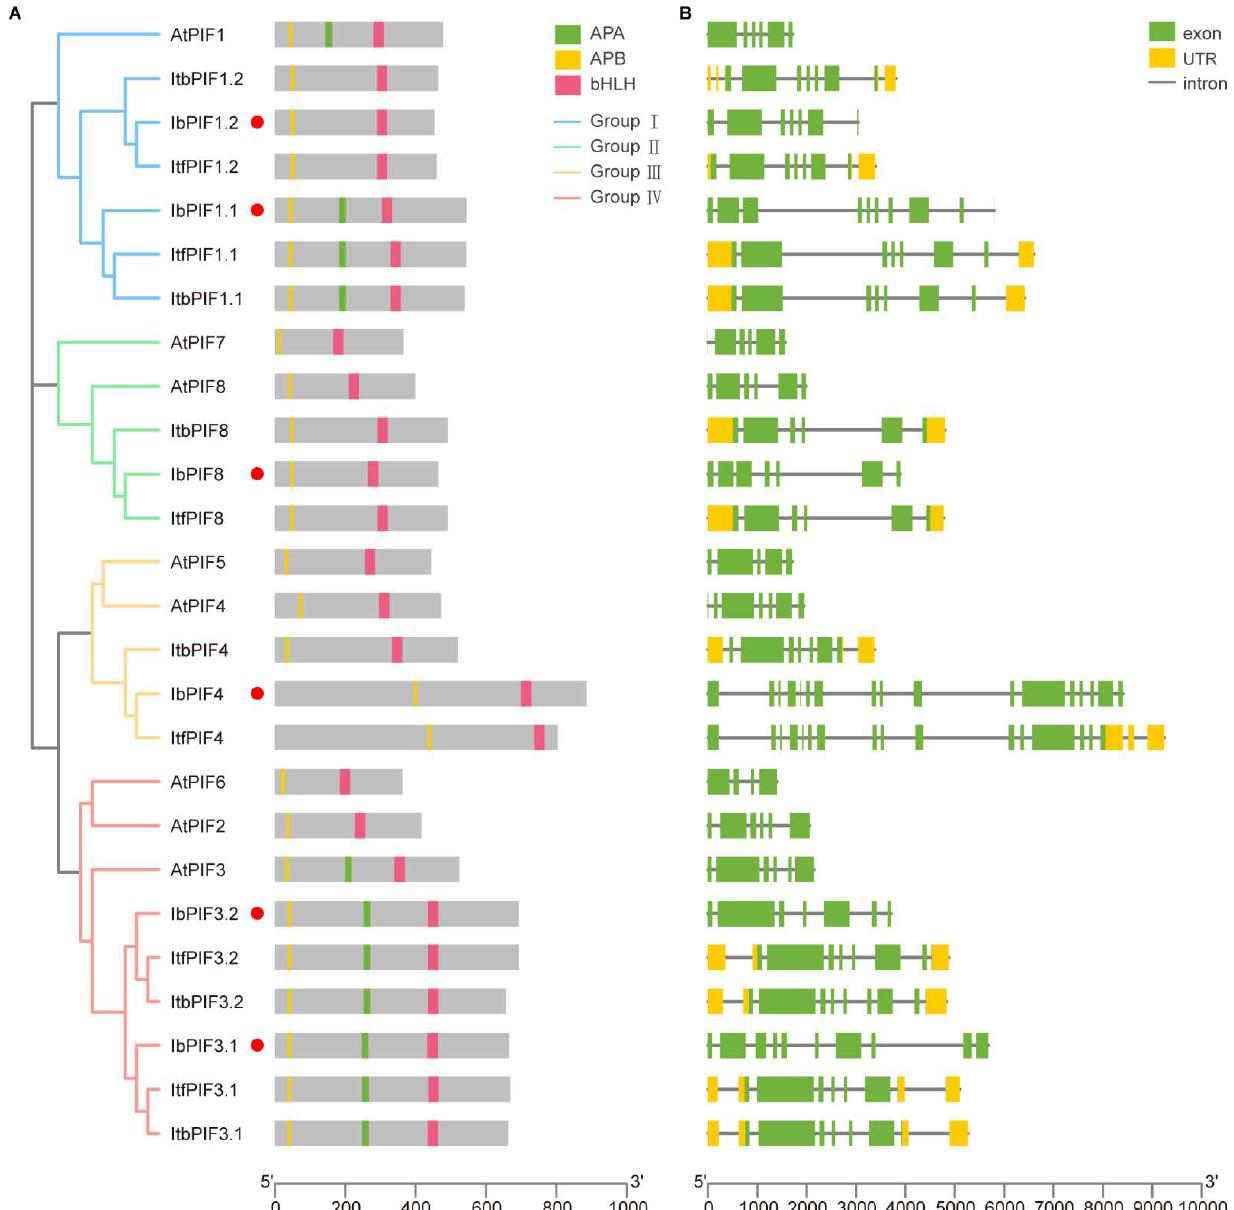
Figure 3. The phylogenetic tree showing that PIFs are distributed into four groups on the left. The red circle represents the IbPIFs. ( A ) Conserved domain structure of PIFs in A. thaliana , I. batatas , I. triloba , and I. trifida . The yellow, green, and pink boxes represent the APB domain, APA domain, and bHLH domain, respectively; and ( B ) exon–intron structure of PIFs in A. thaliana , I. batatas , I. triloba , and I. trifida . The yellow boxes, green boxes, and grey lines represent the UTR, exons, and introns,